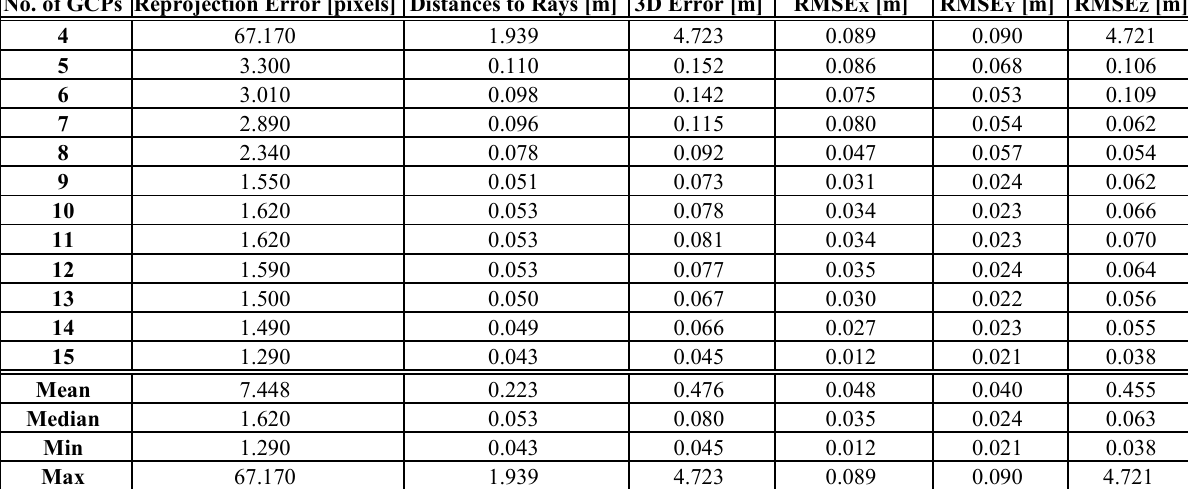
Table 1. Summary of Global RMSE